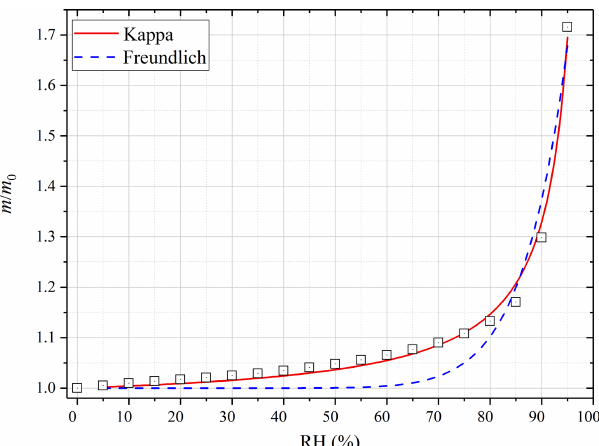
Figure 4. Measured change in sample mass (normalized to that at dry conditions, i.e., m/m 0 ) of pecan pollen as a function of RH (0%–95%) at 25 ◦ C. The experimental data are fitted with the mod- ified κ -Köhler equation (solid red curve) and the Freundlich adsorp- tion isotherm (dashed blue